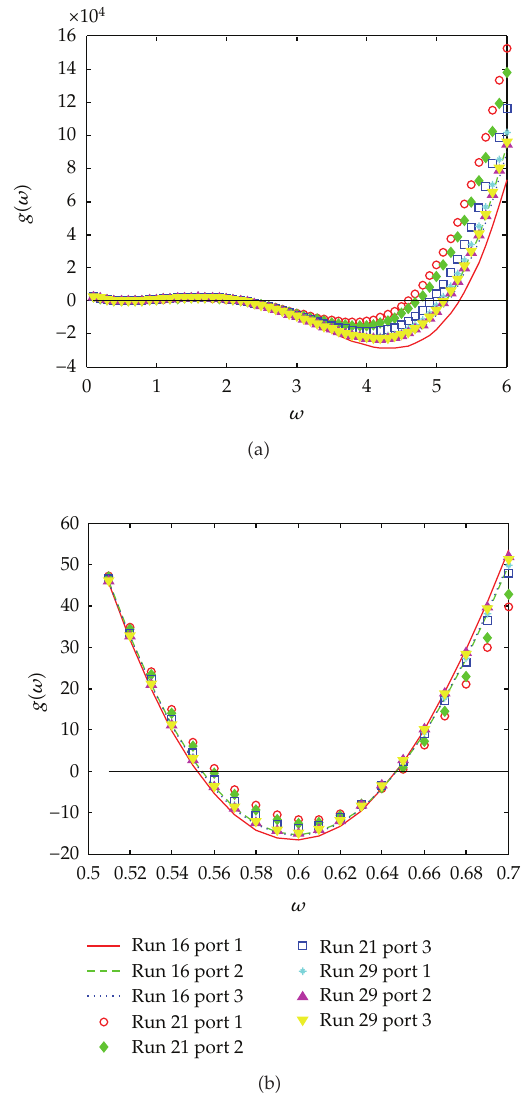
Figure 4: g (cid:2) w (cid:3) for Runs 16, 21, and 29 over (cid:2) a (cid:3) a wide range of ω from 0 to 6 and (cid:2) b (cid:3) a narrow range of ω